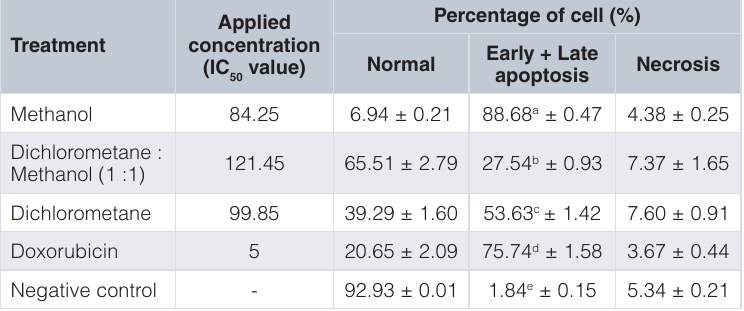
Note: Value after ± shows standard deviation of two replications. Different letter showed the significant difference at the 0.05 level. Statistical analysis is focused to percentage of apoptosis among group.